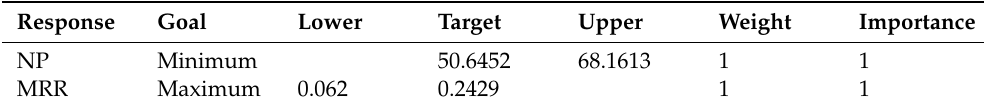
Table 8. Limits of process and performance parameters.